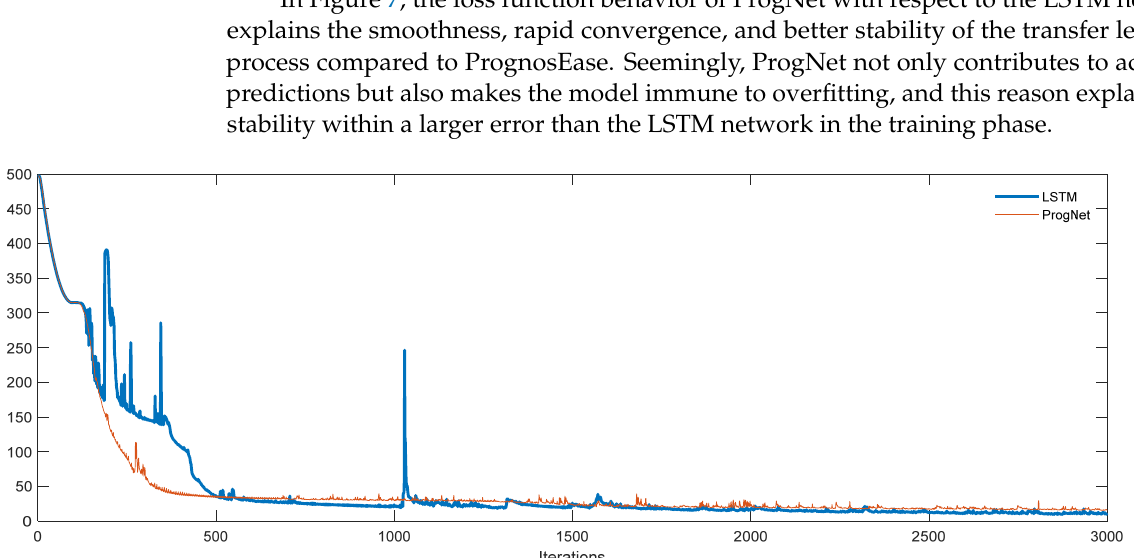
Figure 6. Curve fit results of the entire N-CMAPSS test set.